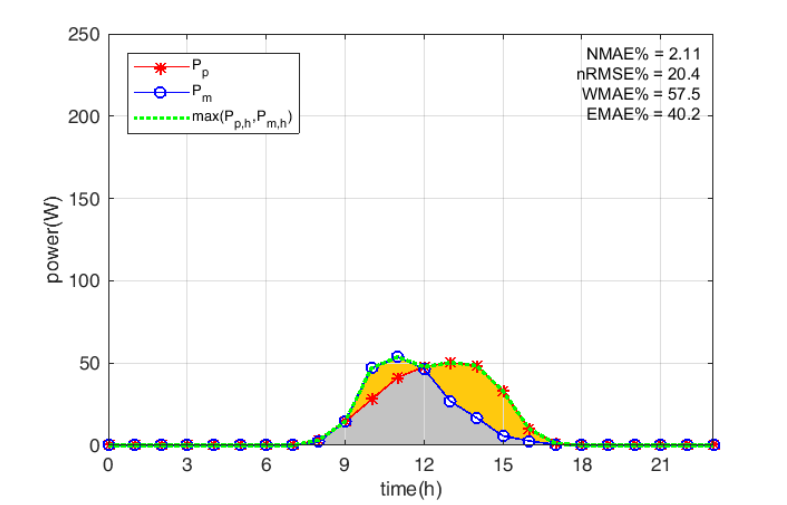
Figure 10. Example of a cloudy day forecast—4 November 2014—with the relevant evaluation